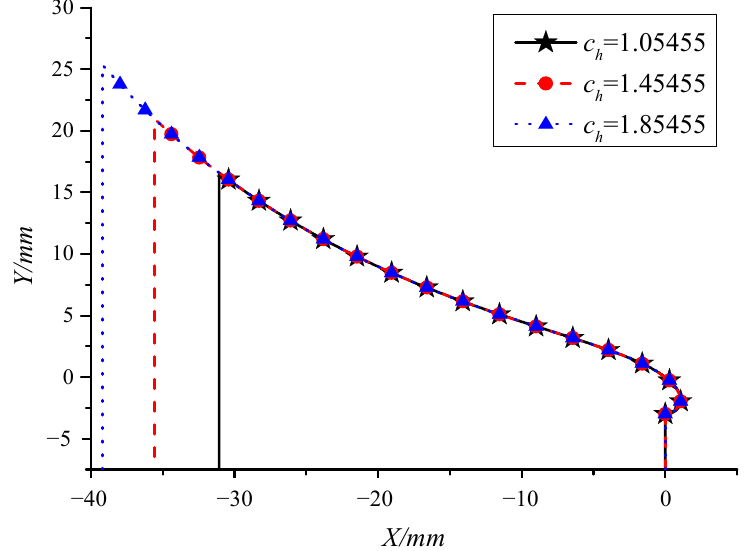
Figure 17. The influence law of c h on the line of action. The influence law of the rack tooth profile offset coefficient c y on the line of action is shown in Figure 18. It can be seen that the change of c h has a certain influence on the start and end points of the line of action. The ordinate of the starting point of the line of action increases with the increase of c y , the abscissa of the end point of the line of action decreases with the increase of c y , and the ordinate of the end point of the line of action increases with the increase of c y . The length of the line of action increases with the increase of c y